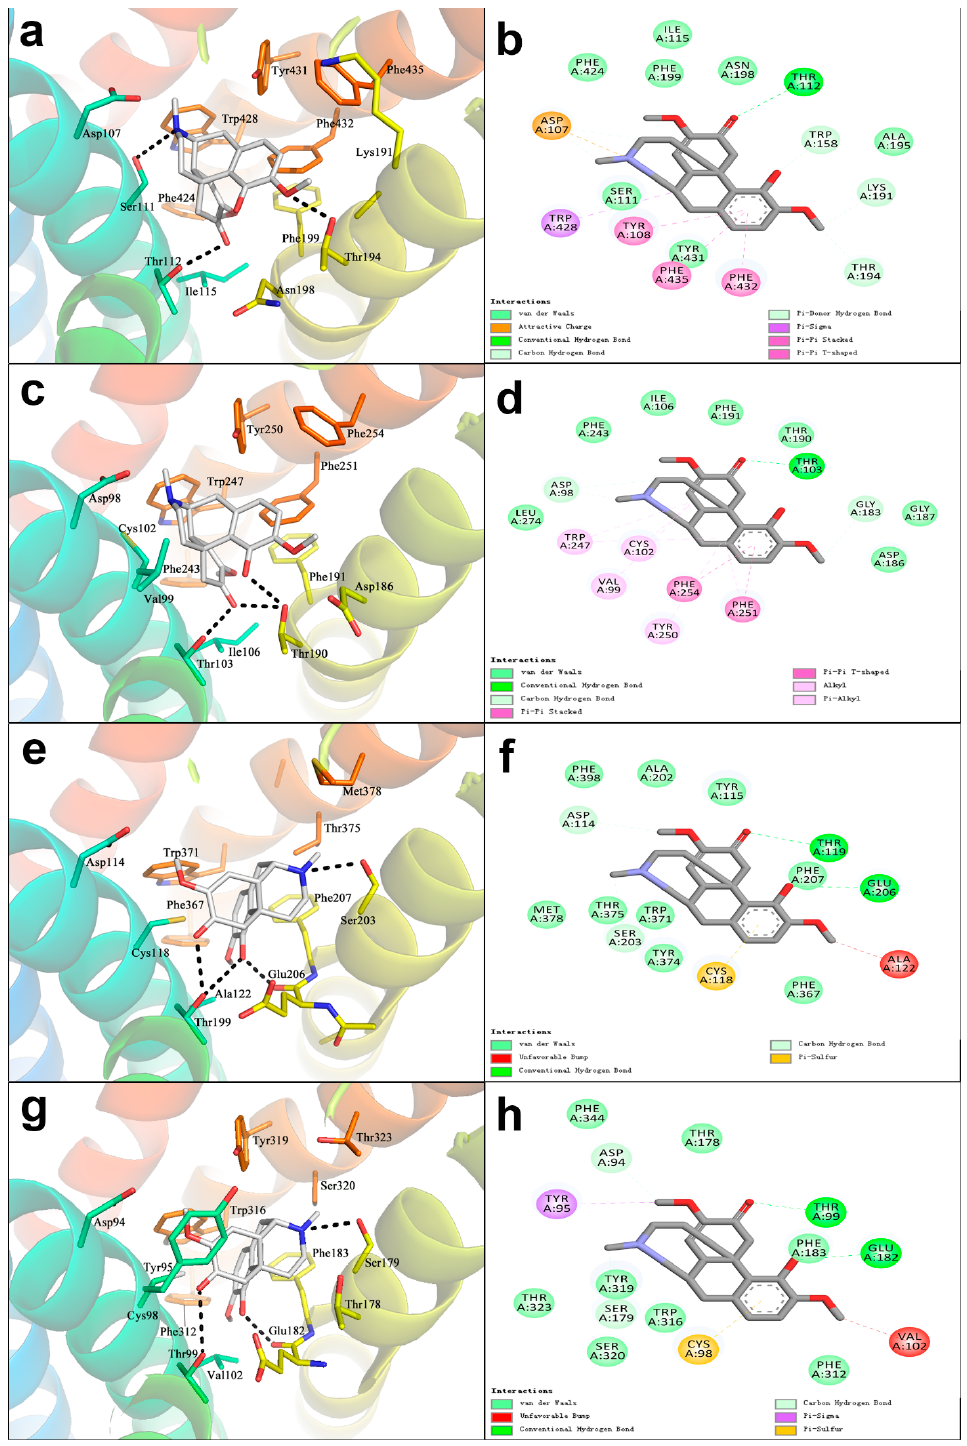
Figure 4. Binding mode of SIN and histamine receptors. ( a ) Conformational binding mode of H1R and SIN after docking, where: The gray ball-and-stick model represented the conformation of post-docking SIN and the interactions of amino acid residues, and black lines marked the hydrogen-bond; ( b ) two-dimensional binding mode diagram of H1R-SIN; ( c ) conformational binding mode of H2R and SIN after docking; ( d ) two-dimensional binding mode diagram of H2R-SIN; ( e ) conformational binding mode of H3R and SIN after docking; ( f ) two-dimensional binding mode diagram of H3R-SIN; ( g ) conformational binding mode of H4R and SIN after docking; ( h ) two-dimensional binding mode diagram of